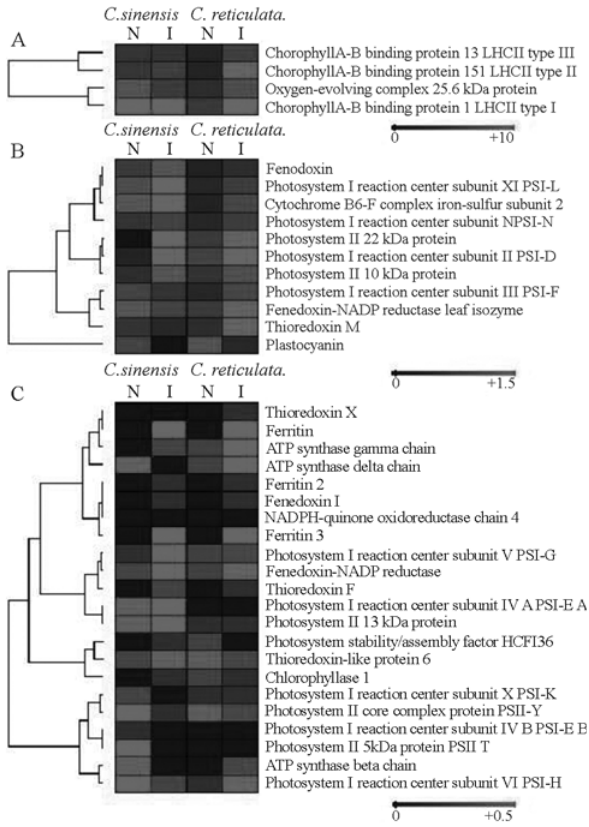
Figure 3 - Hierarchical clusterization by expression pattern of photosys- tems subunits- and Z scheme-related expressed sequences in C. sinensis and C. reticulata , infected (I) or not infected (N) with Xylella fastidiosa . Black represents ‘no expression’; light gray represents ‘maximum expres- sion’, with gray intensity proportionally representing intermediate expres- sion